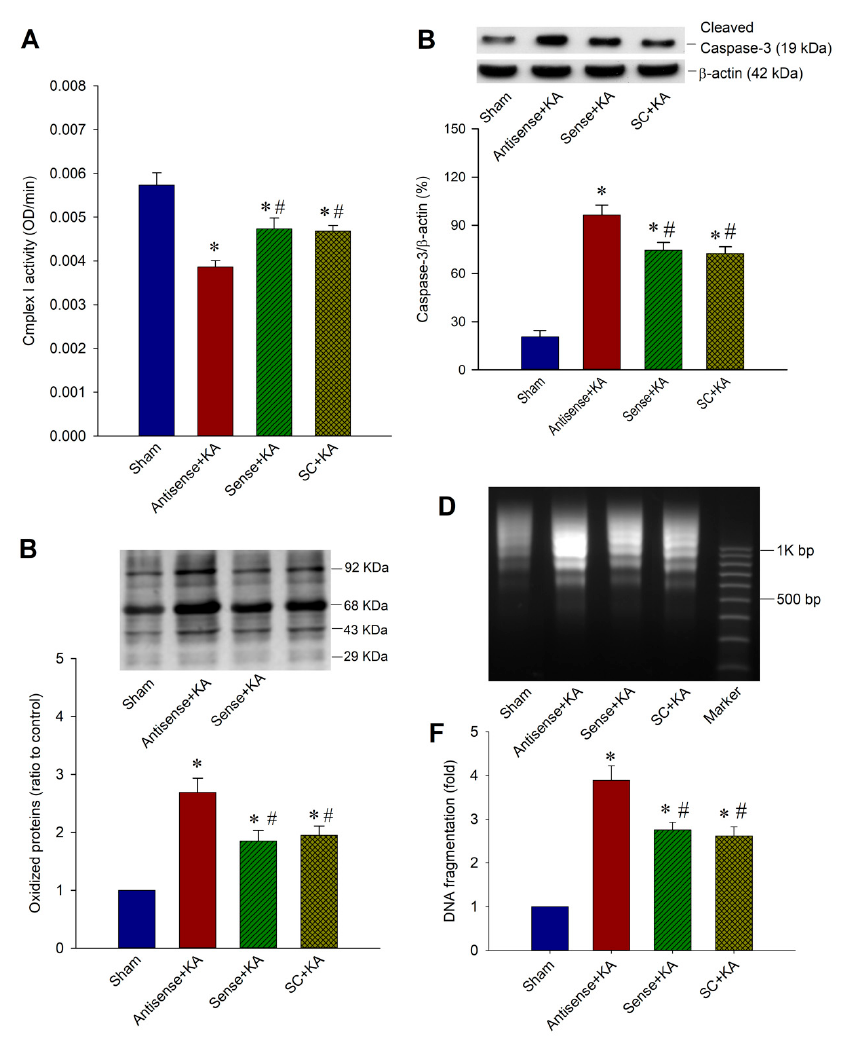
Figure 5. Pre-treatment of Sirt1 antisense ODN augments related neuronal cell damage in the hippocampus following kainic acid (KA)-induced status epilepticus. ( A ) Enzyme assay for the activity of Complex I in the mitochondrial fraction isolated from the CA3 subfield of the hippocampus in the sham-control animals, or three days after microinjection of KA (0.5 nmol) into the left hippocampal CA3 subfield in animals which received a microinjection into the bilateral CA3 subfield of antisense ODN against Sirt1 , or sense or scrambled (SC) ODN (1 nmol). ( B ) Representative gels (inset) or ratio to sham control change in protein oxidation detected in samples collected from the CA3 subfield of the hippocampus in animals that received Sirt1 antisense, sense, or SC ODN. Total proteins were extracted from the hippocampal CA3 subfield in the sham-control animals, or seven days after the microinjection of KA (0.5 nmol) into the left hippocampal CA3 subfield in animals that received a microinjection into the bilateral CA3 subfield of antisense ODN against Sirt1 , or sense or SC ODN (1 nmol), followed by immunoblot analysis for the extent of protein oxidation. ( C ) Representative gels (inset) or changes in activated caspase-3 (19 kDa) relative to β -actin protein, detected in the cytosolic fraction of samples collected from the CA3 subfield of the hippocampus in sham-control animals, or